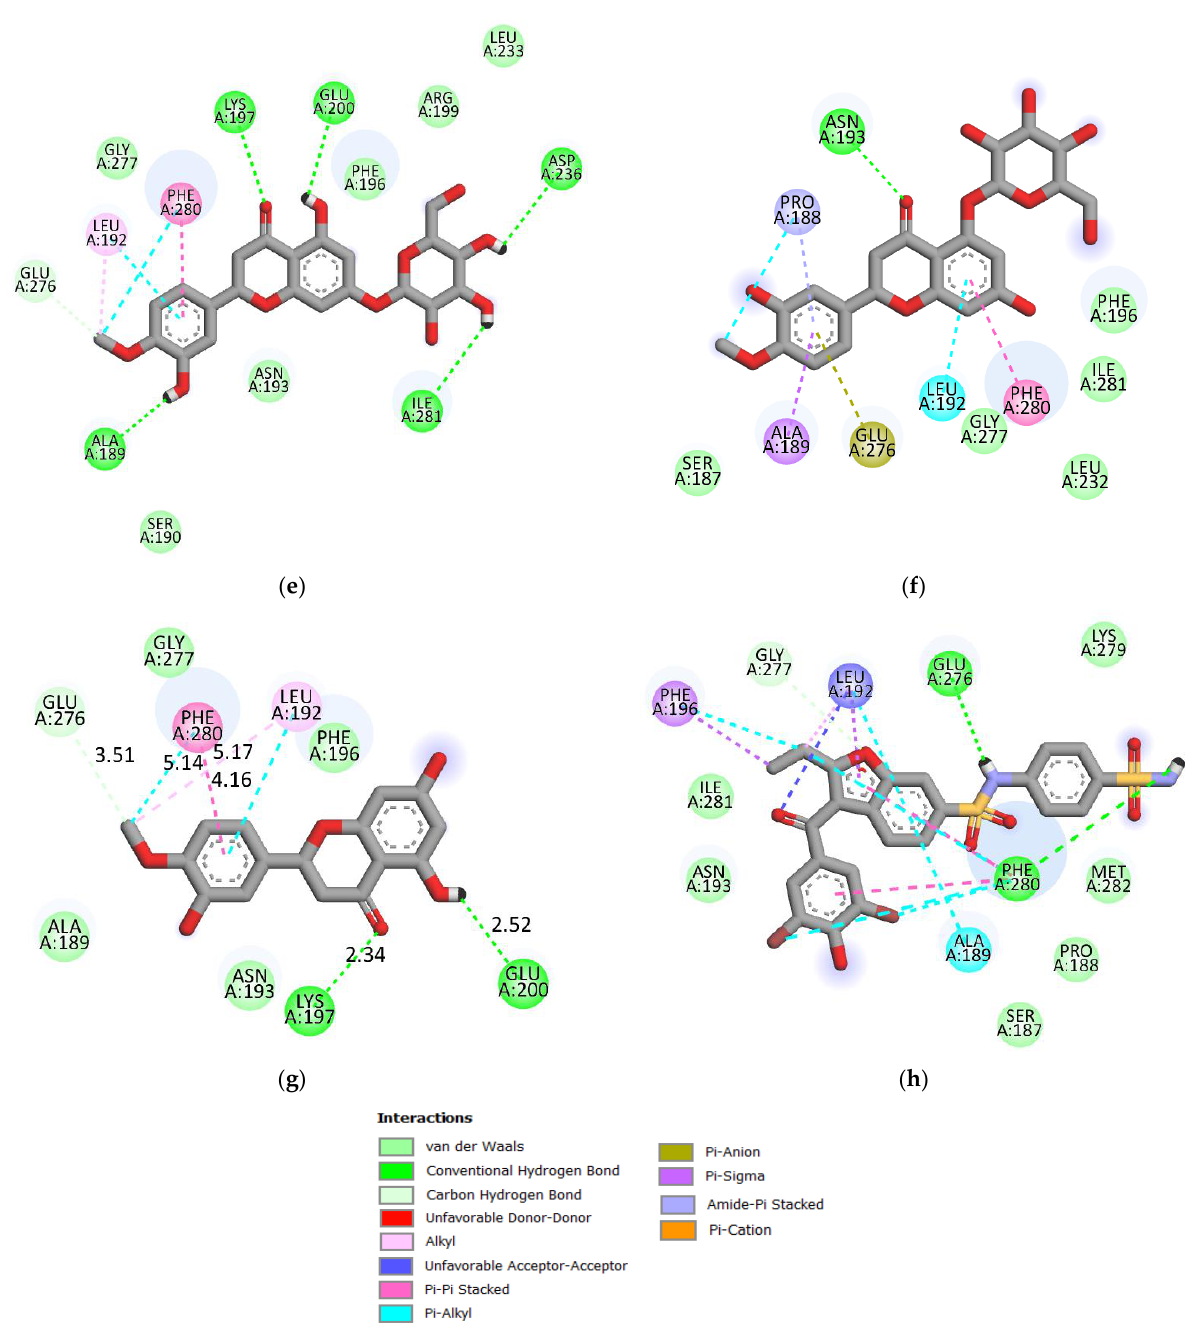
Figure 5. 2D molecular docking models of the catalytic site hesperidin ( a ), neohesperidin ( b ) and compound 23 ( c ), and allosteric site hesperidin ( d ), hesperetin 7- O -glucoside ( e ), hesperetin 5- O -glucoside ( f ), hesperetin ( g ) and compound 2 ( h ) for PTP1B inhibition. Table 2. Binding site residues and docking scores of flavonoids in the tyrosine phosphatase 1B protein using the AutoDock vina program.